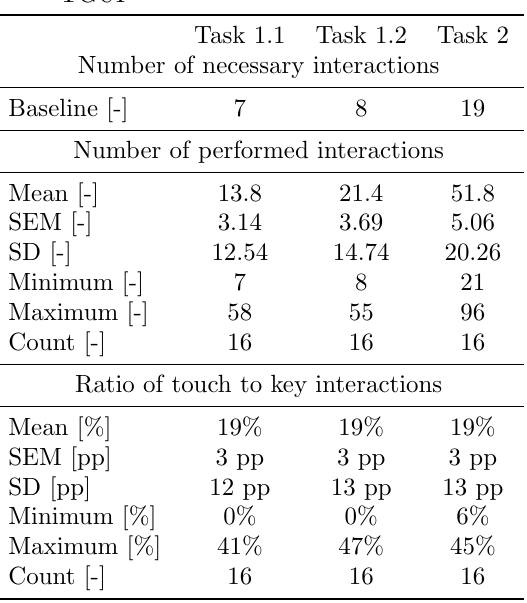
Table 5: Quantitative results of interactions with TGUI Task 1.1 Task 1.2 Task 2